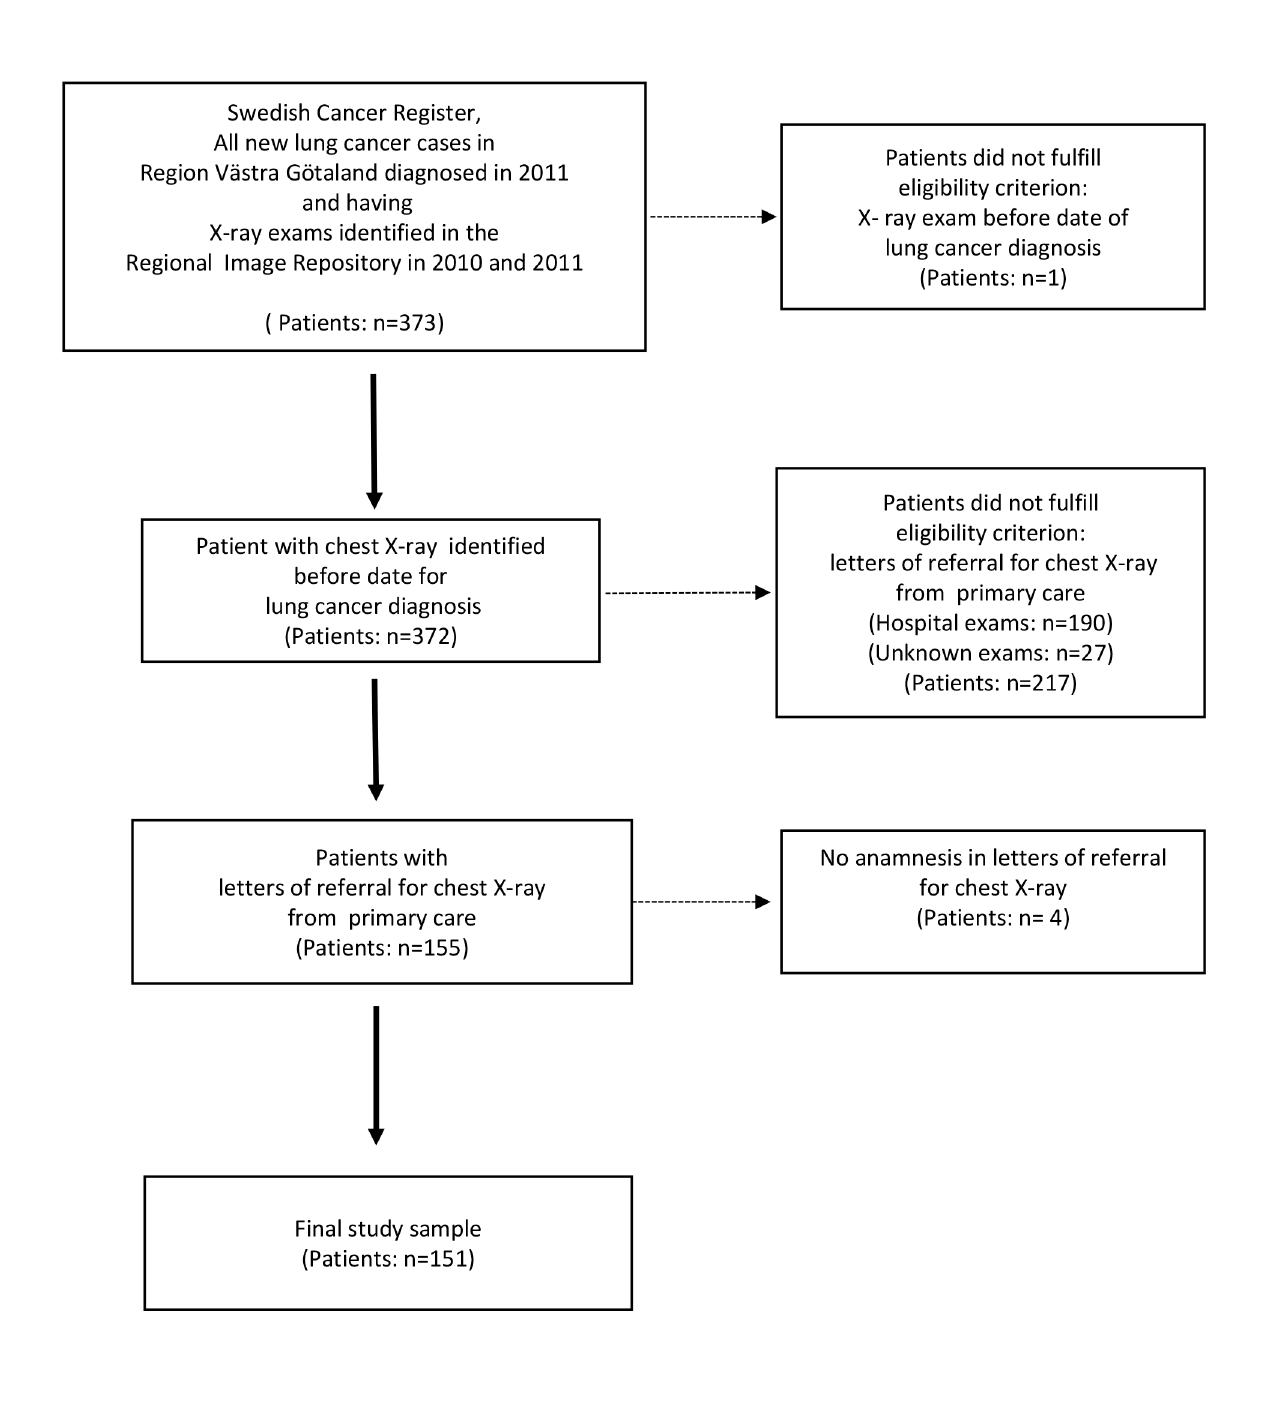
Figure 1. Selection process of patients with lung cancer in primary care with first referral to chest X-ray examination from primary care.